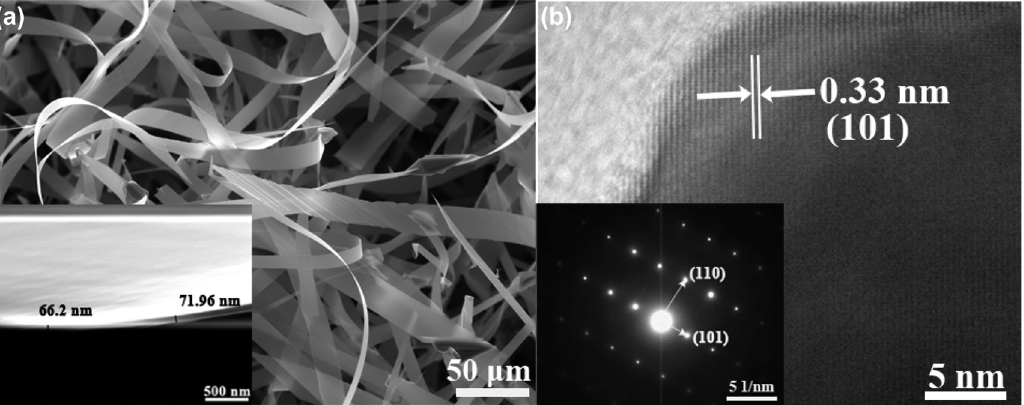
Figure 2: Microstructure images of CdSe NBs. (a) SEM and thickness (inset) and (b) HRTEM images and SAED patterns (inset) of CdSe